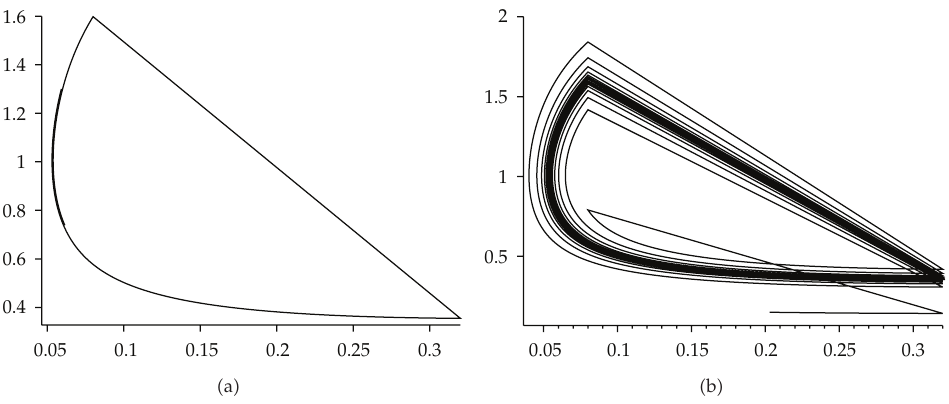
Figure 4: (cid:9) a (cid:10) Existence of positive period-1 solution; (cid:9) b (cid:10) stability of positive period-1